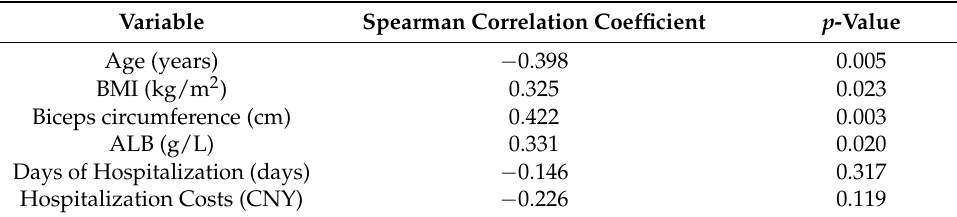
Table 2. Spearman correlation between PhA and clinical parameters.